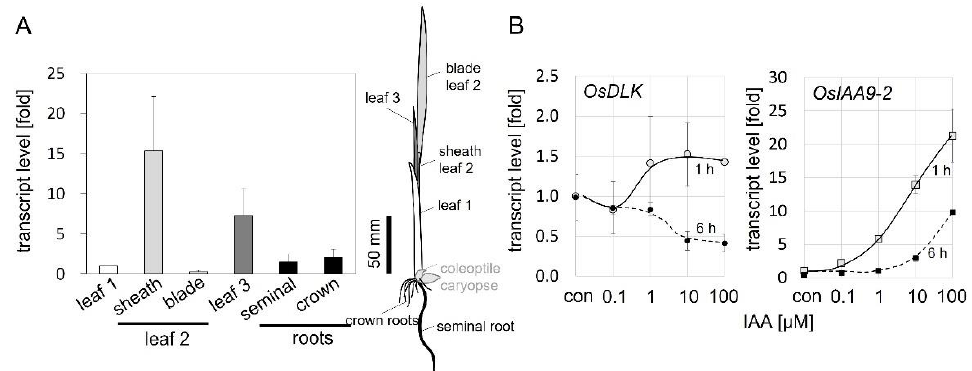
Figure 2. Regulation pattern of OsDLK in seedlings of O. sativa ssp. japonica ‘Nipponbare’. ( A ) Steady-state transcript levels of OsDLK in different organs of seedlings raised for 10 days under white light. Values are expressed relative to the level found in the first leaf. The position of these organs is indicated in the schematic drawing. Data represent mean values and SE from at least 12 individuals collected in three different experimental series. ( B ) Dose–response curve for the auxin response of OsDLK in coleoptile segments. Segments of etiolated rice coleoptiles were depleted from endogenous auxin for 1 h and then incubated in different concentrations of indole acetic acid (IAA). As a control for auxin responsivity, transcripts for the auxin-responsive gene OsIAA9-2 were measured in parallel. Data represent means and SE from three independent experimental series with ten individual segments per measurement.